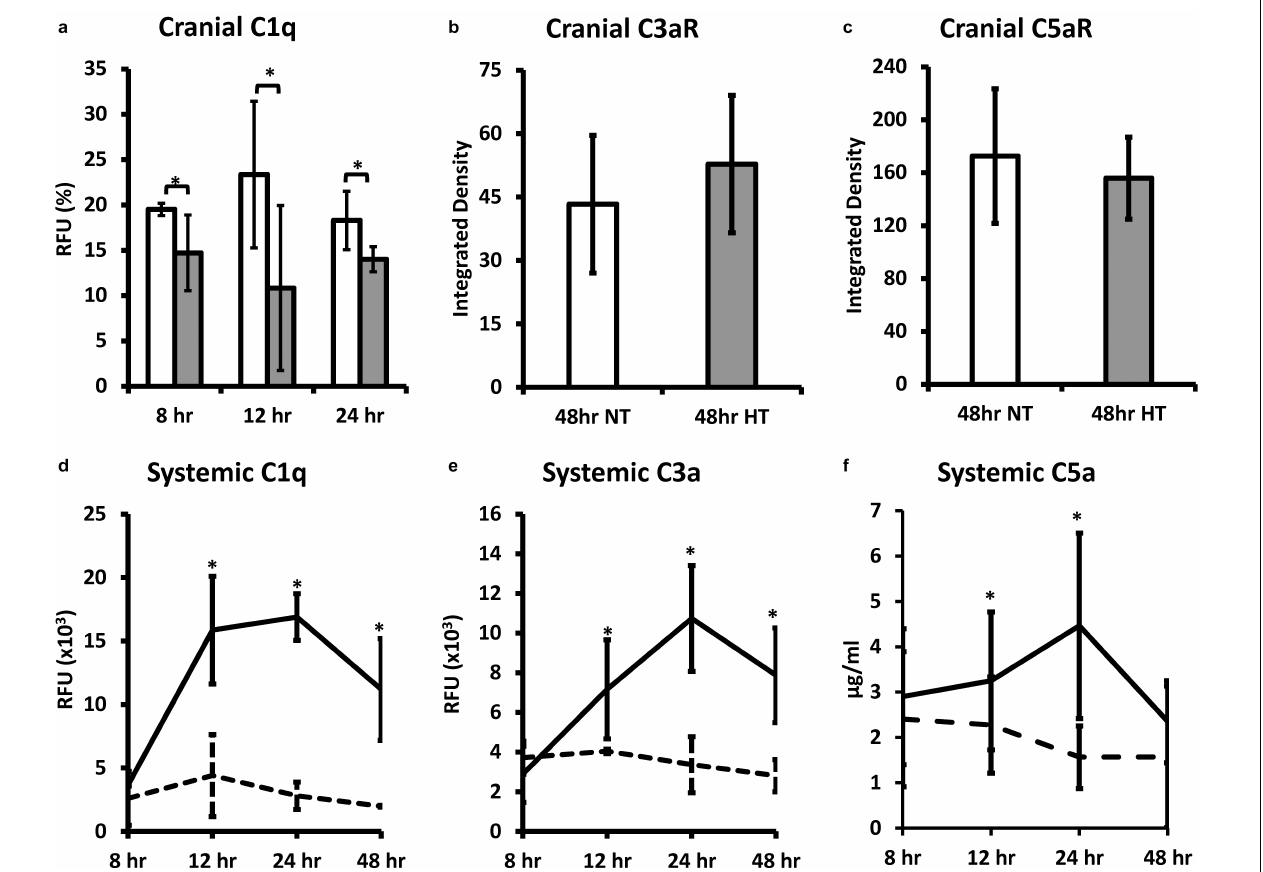
FIGURE 4 | HT decreases systemic and brain complement expression in neonatal HIE. Whole brain C1q levels in NT animals were significantly higher than HT treated animals at 8, 12, and 24 h after the initial insult (a) . There were no significant differences in the expression of whole brain C3aR (b) or C5aR (c) between NT and HT treated groups. C1q levels in the plasma of NT animals were significantly higher than HT treated animals at 8, 12, and 24 h after injury (d) . Systemic C3a (b) and C5a (c) levels in NT animals were significantly higher than HT treated animals at 12 and 24 after injury. The differences in C5a persisted out to 48 h. ( n = 7 animals per group, solid lines/white bars – NT; dotted lines/gray bars – HT; error bars denote ± SD, * denotes P < 0.05).